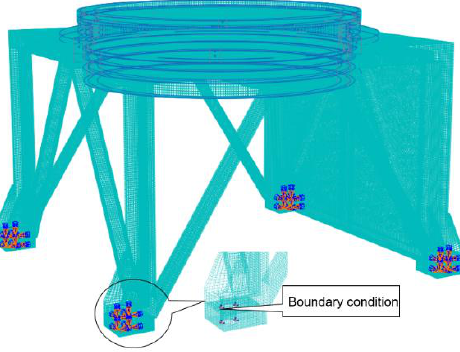
Figure 5. Finite element analysis boundary conditions.